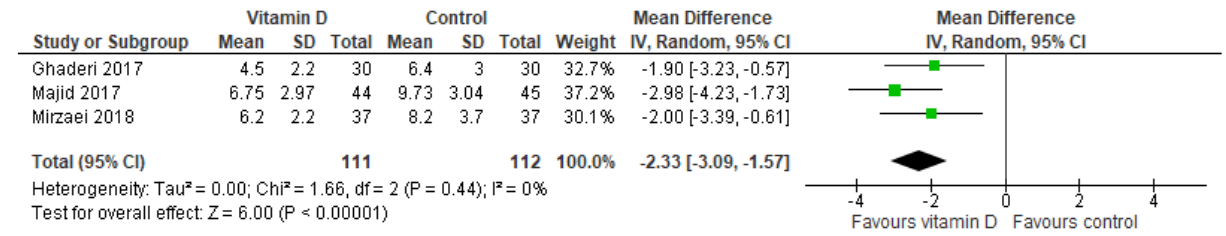
Figure 3. Meta-analysis of the effect of vitamin D supplementation on sleep quality assessed by the Pittsburg Sleep Quality Index. Mean differences for each study are represented by squares, and 95% Confidence Intervals are represented by the lines through the squares. The pooled mean differences are represented by diamonds. Between-study heterogeneity was assessed with the use of the I 2 statistic [25,27,30].